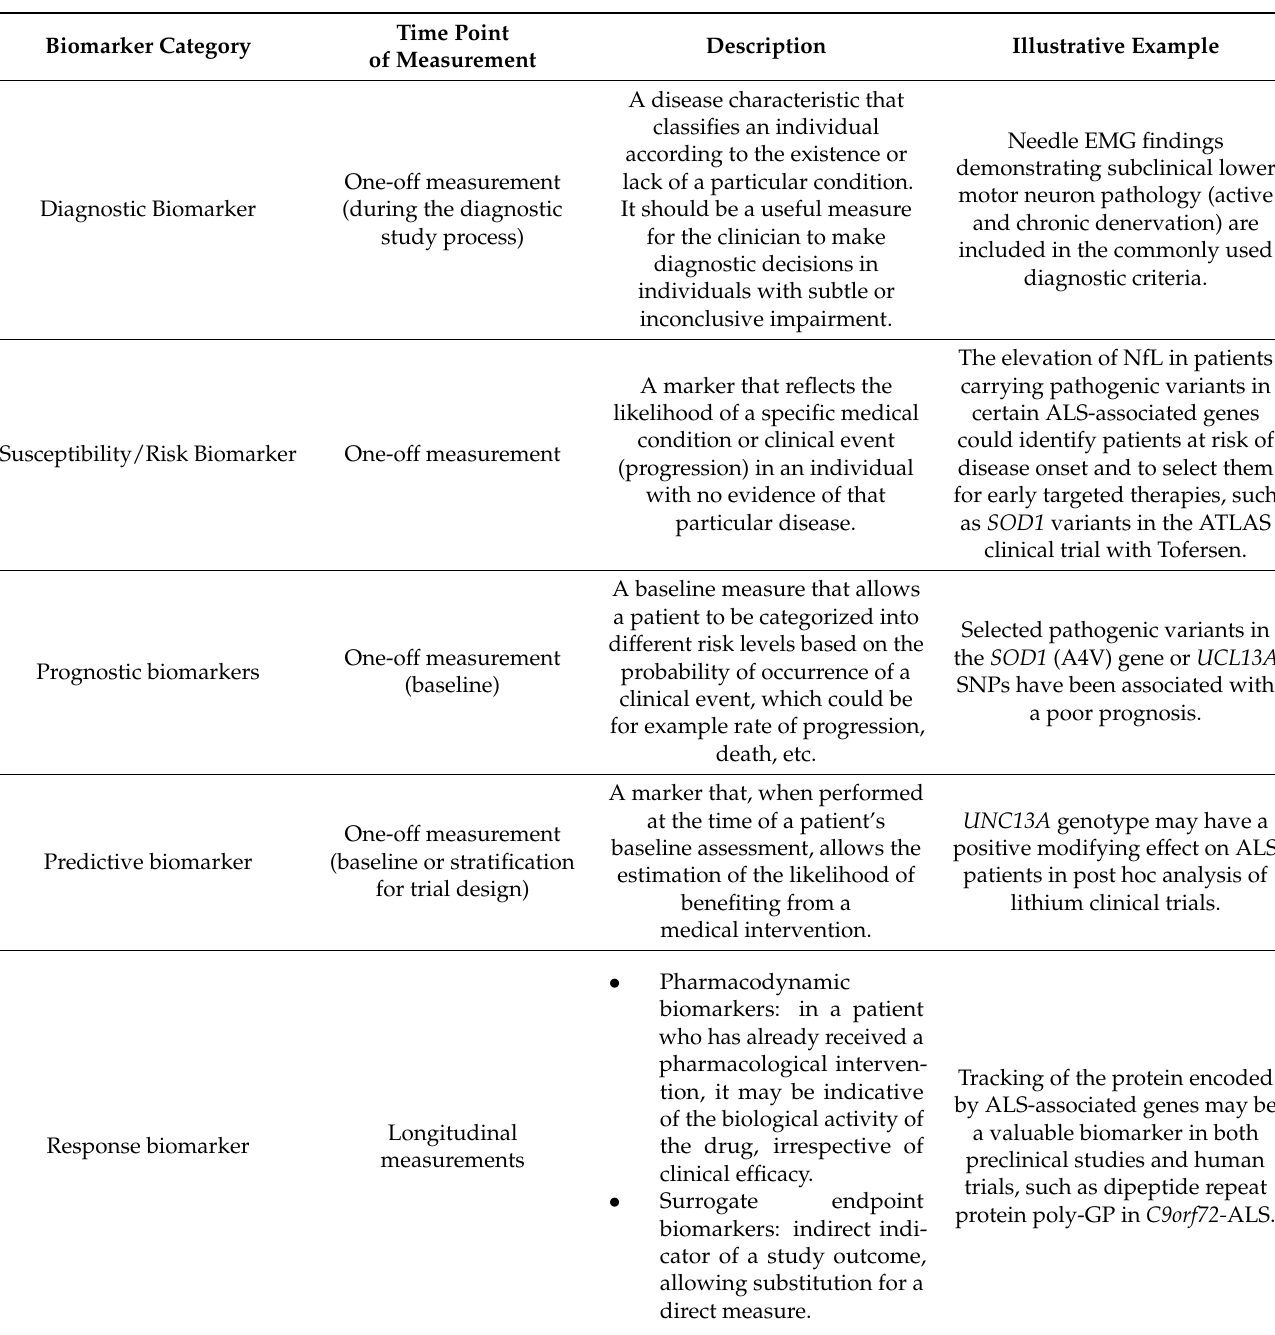
Table 1. Types of biomarkers in the field of Amyotrophic Lateral Sclerosis